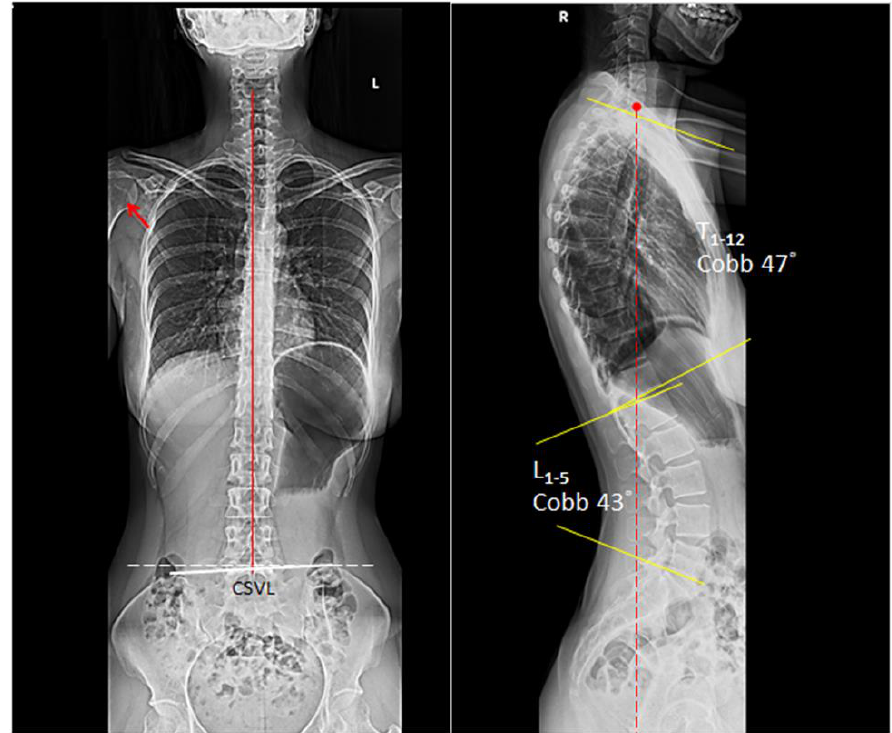
Figure 2. At 9 months follow-up, the thoracic kyphotic angle reduced to 47° and the GERD also resolved. The patient remained pain- and GERD-free at the 12-month follow-up visit. In a balanced state, the C7 plumb line (dashed red line) should fall within 3 cm, either anterior or posterior, of the posterosuperior corner of the S1